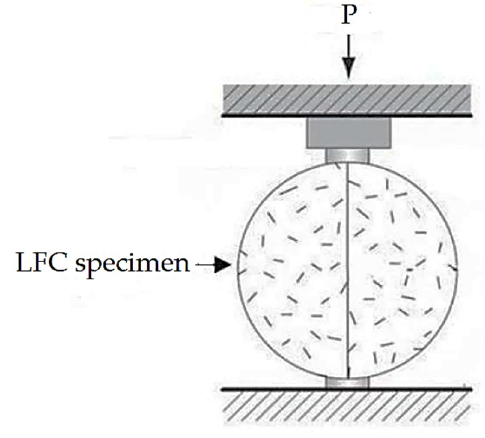
Figure 7. Schematic diagram of splitting tensile strength test.